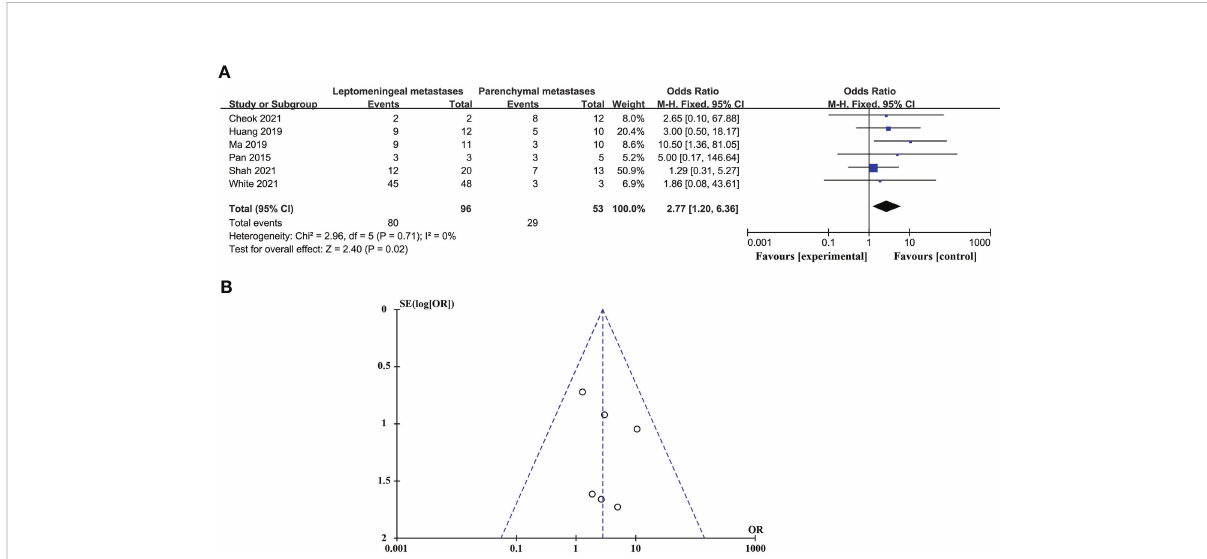
FIGURE 2 Comparison of the diagnostic advantages of CSF liquid biopsy techniques in BPM and LM. (A) . Forest plot of diagnostic advantages of CSF liquid biopsy techniques in BPM and LM. (B) . Funnel plot of diagnostic advantages of CSF liquid biopsy techniques in BPM and